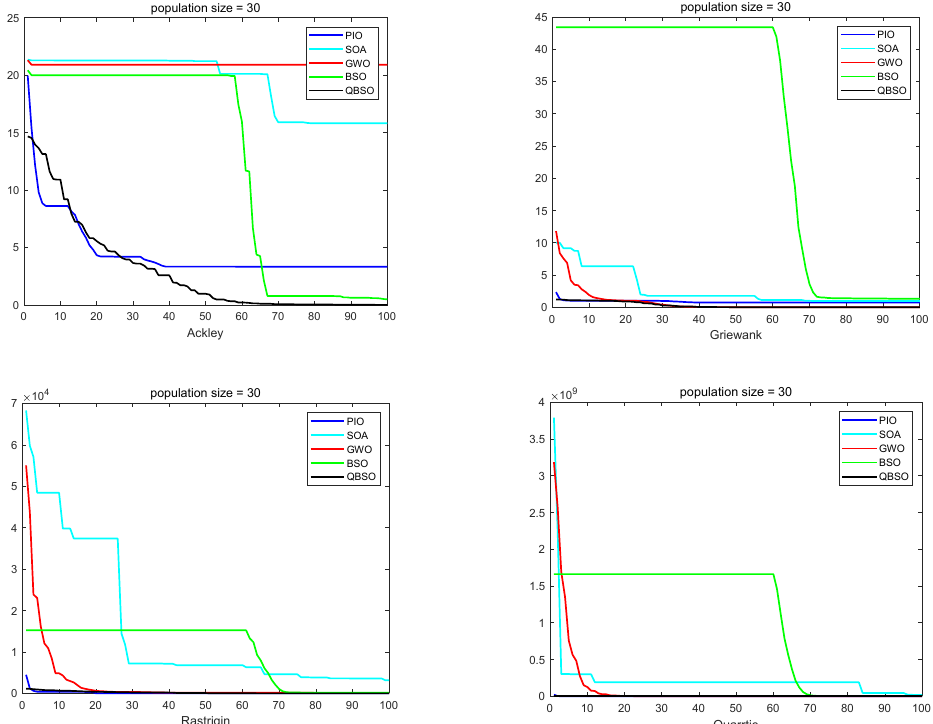
Figure 6. The iteration curves when solving the multimodal benchmark functions with four algo- rithms.